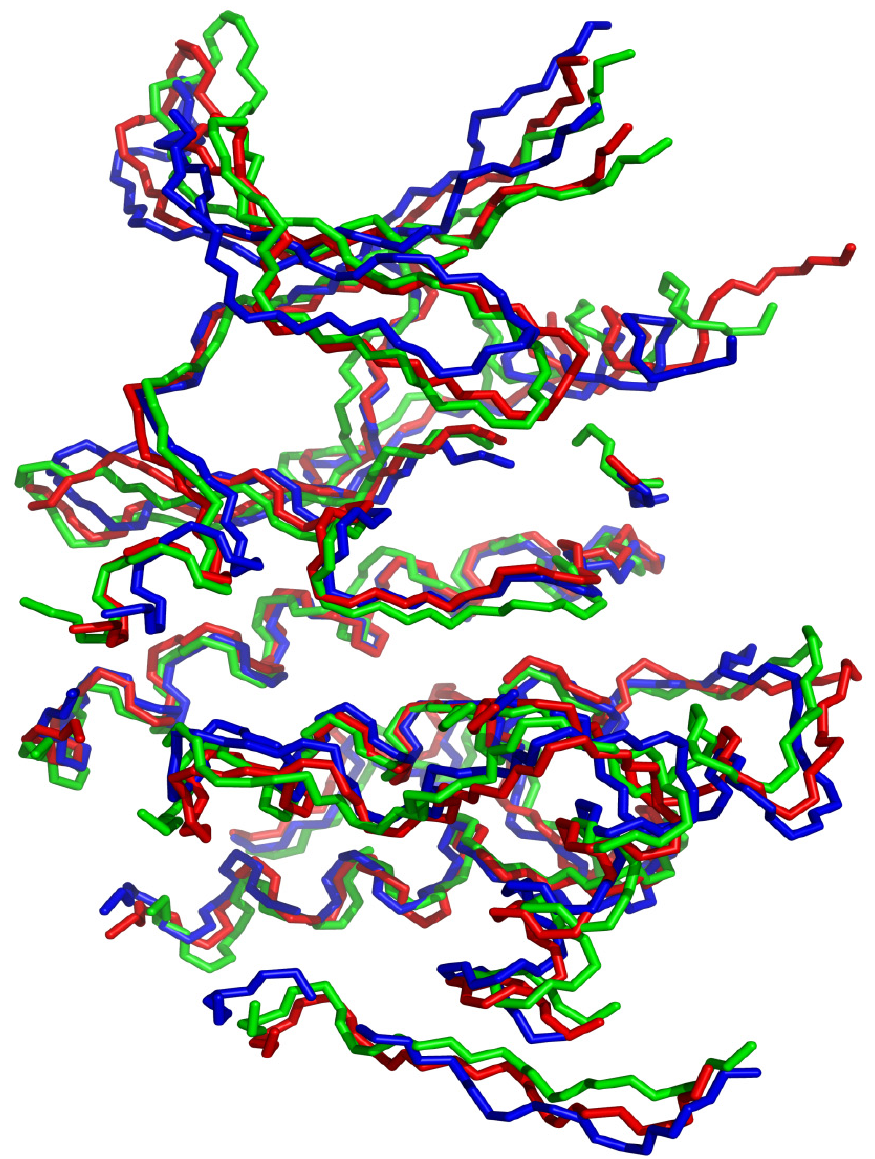
Figure 4. Backbone (C , C, N) of ERK2 (blue), GSK β (red) and CDK5 (green) included in α the trajectory analysis.